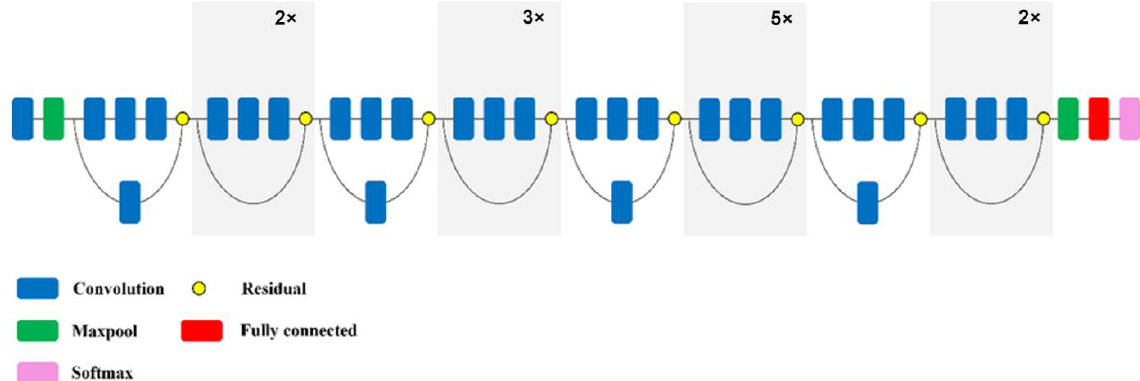
Figure 7. Simplified structure of the ResNet network model [47].